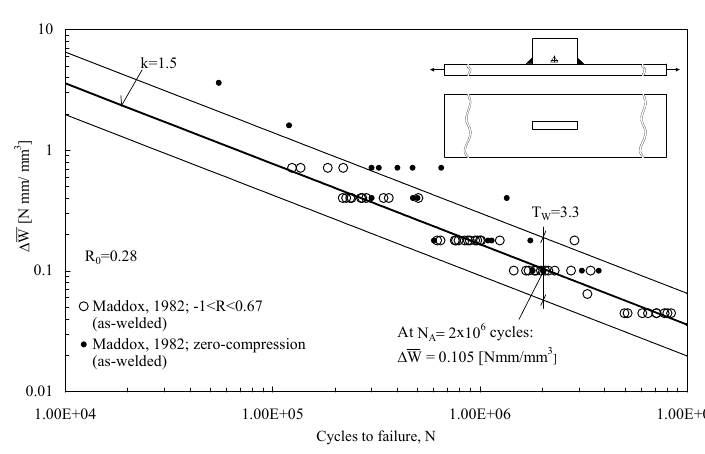
Figura 7: Resistenza a fatica di giunti saldati con irrigidimento longitudinale in funzione del valore medio